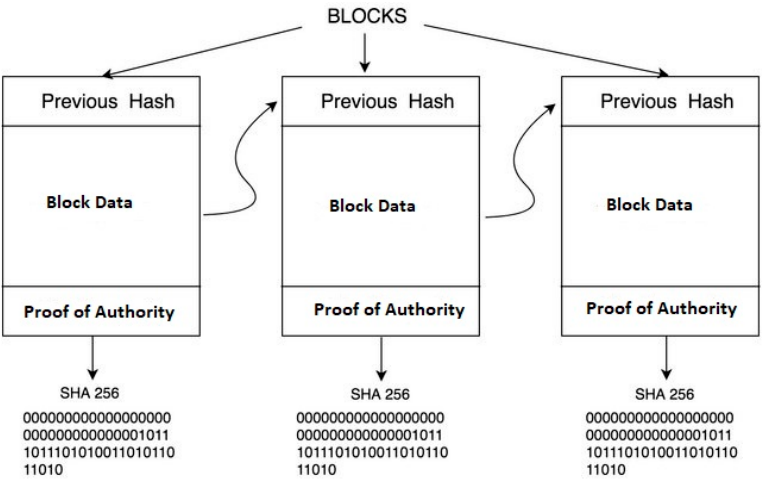
Figure 7. Blockchain structure and consensus algorithms.